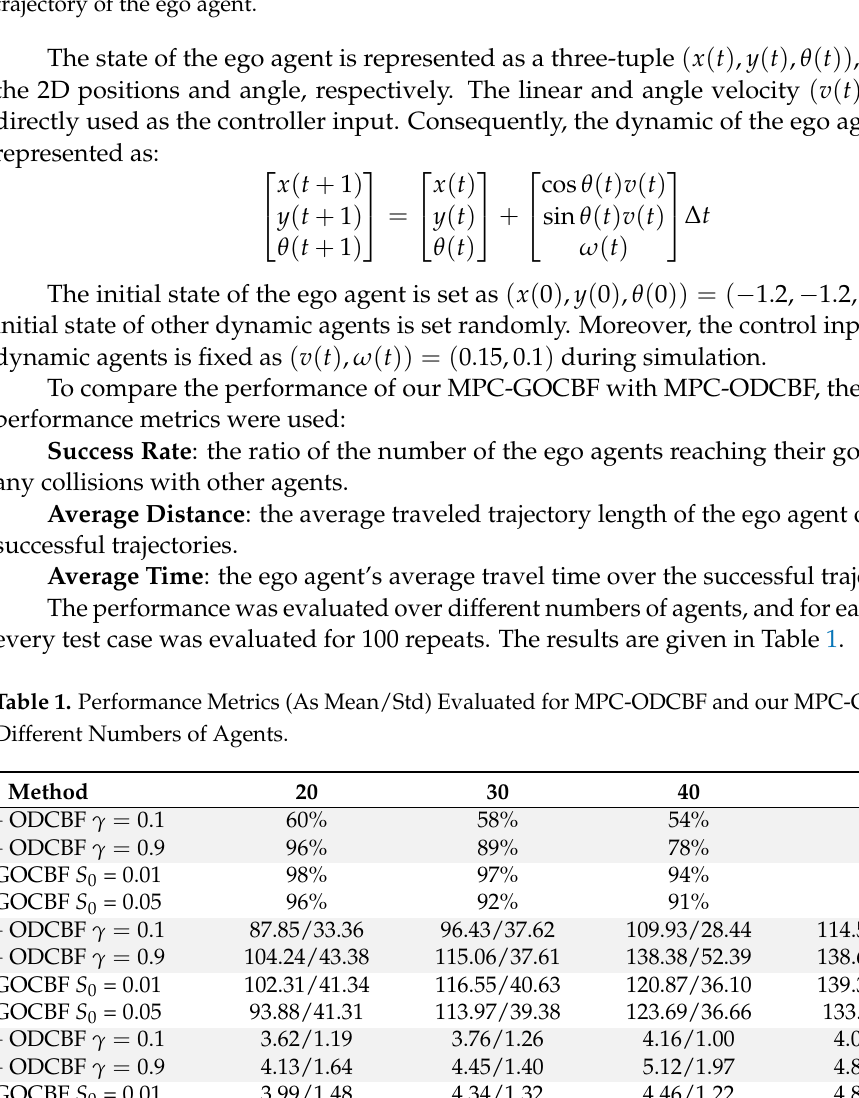
other agents used as dynamic obstacles are represented as blue: ( a ) a snapshot of the simulation; ( b ) a